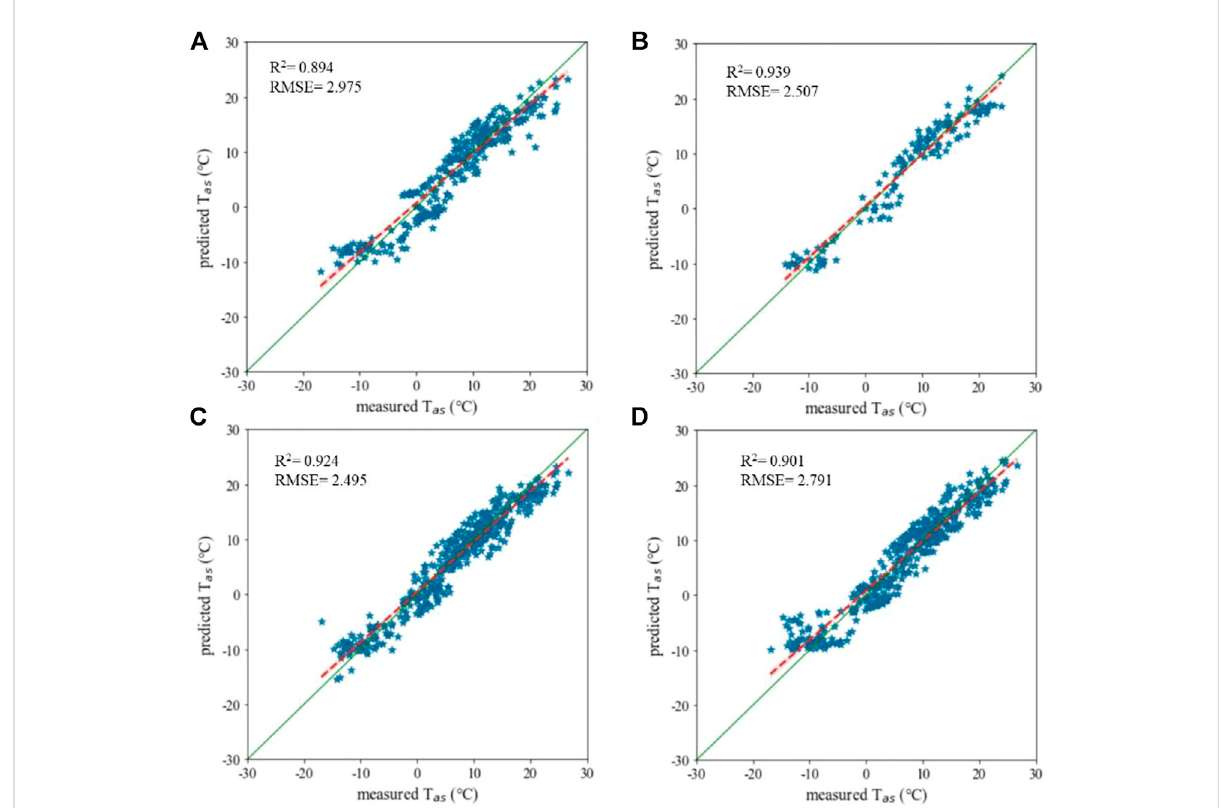
FIGURE 3 Evidence for Eq. 11 from the PLSR training stage (A) , testing stage (B) , and ANN analyses before excluding the secondary contributors (C) and after excluding the secondary contributors (D) . Note: T as is the air temperature at 10 cm above the soil surface. All other environmental variables are considered potential contributors to T as